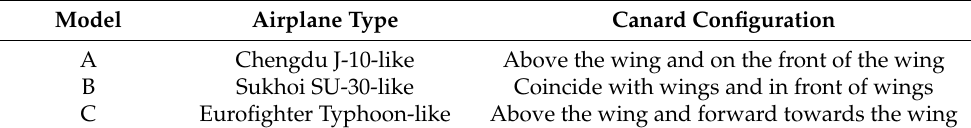
Table 1. Configuration of aircraft specimen models.